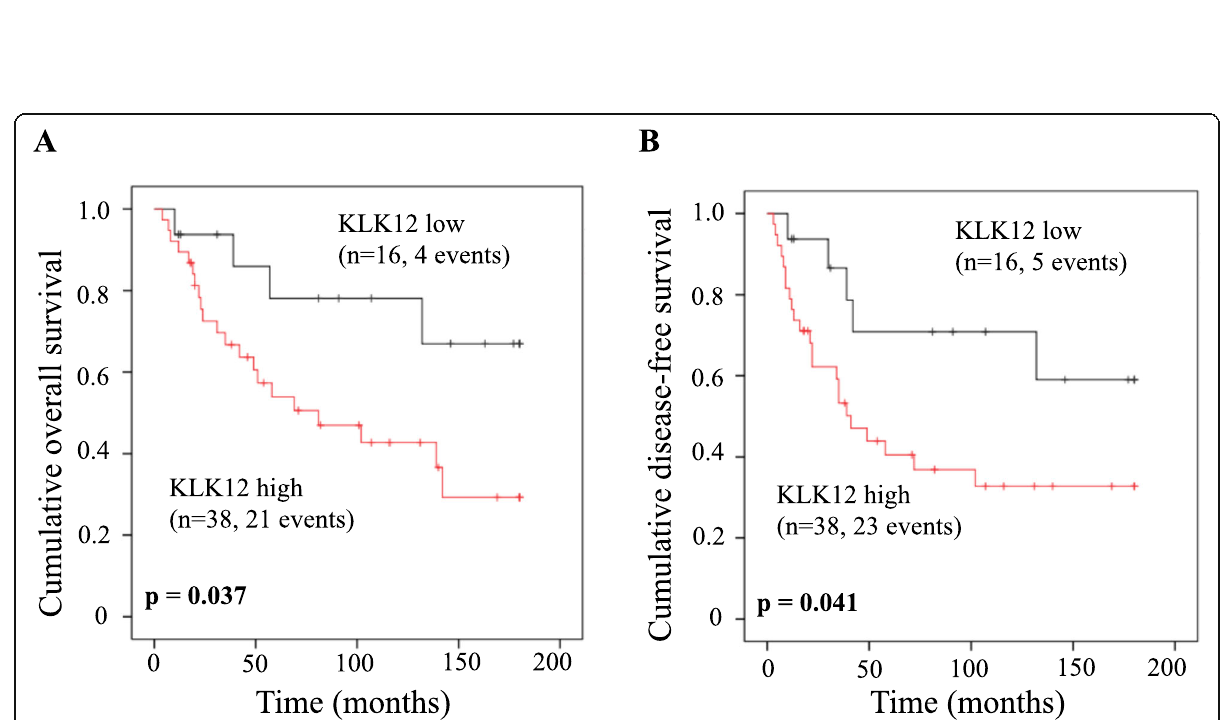
Fig. 2 Overall survival (OS) and disease-free survival (DFS) of triple-negative breast cancer patients in the sub-group of patients displaying positive KLK12 mRNA expression in primary tumor tissues. Patients with elevated KLK12 mRNA expression levels display a significantly worse OS ( a Kaplan- Meier analysis, p = 0.037) and DFS ( b p = 0.041), respectively, compared to patients with low KLK12 mRNA expression levels